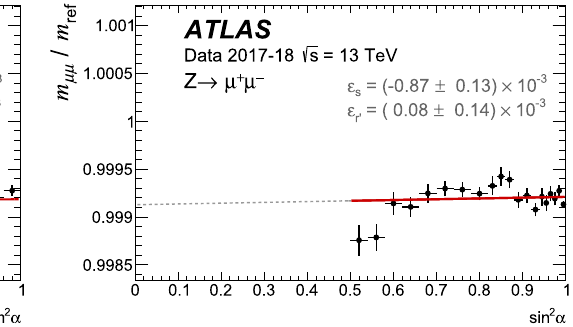
range.Errorbarsrepresentthestatisticaluncertainty.Theredlinesshow the fit to Eq. (28) from which the values of ε s and ε r (cid:5) are extracted